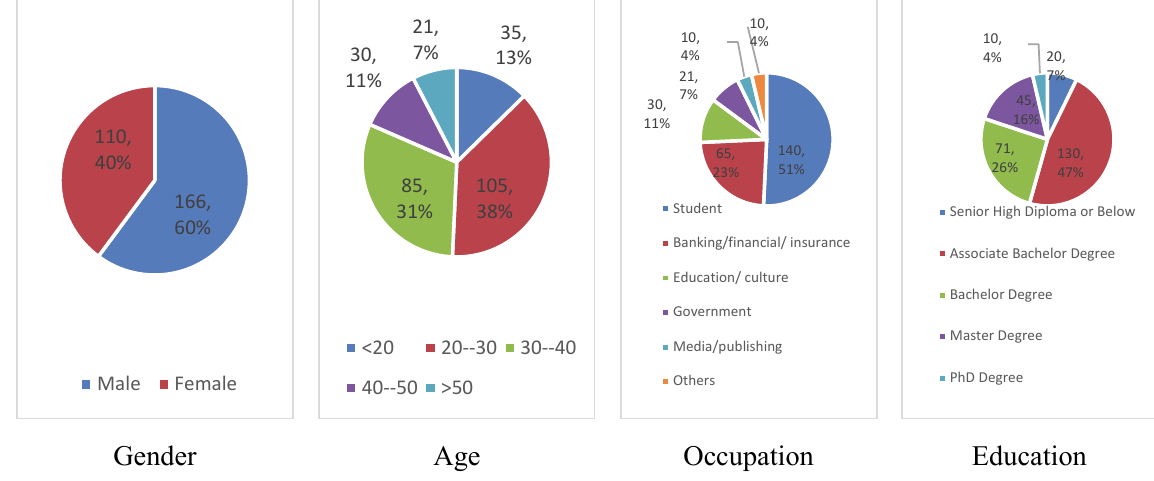
Fig. 2. Personal characteristics of the participants